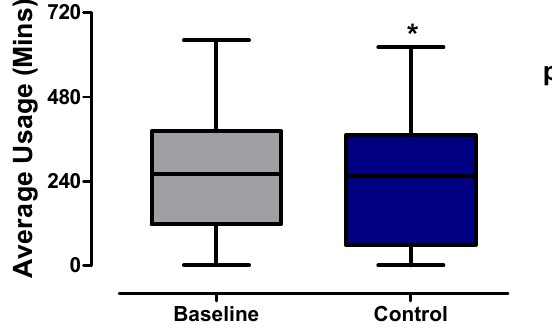
Figure 3. Average usage per day (minutes) and compliance ( ≥ 4 h usage day %) in controls at two time points: 30 days before (baseline) and 30 days after the telemonitoring phase (control). Wilcoxon—Rank test was used to compare the group. * p value ≤ 0.05 was considered to be significant.